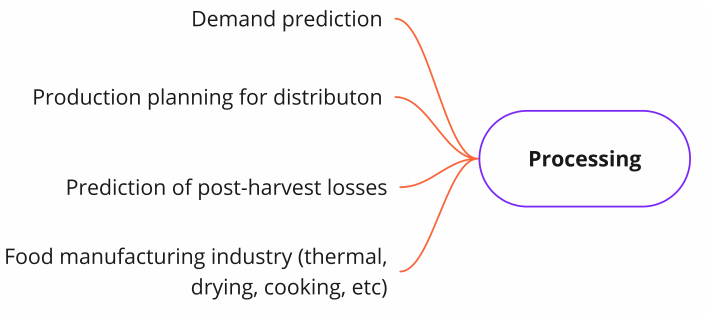
Figure 7. FSC problems in the processing